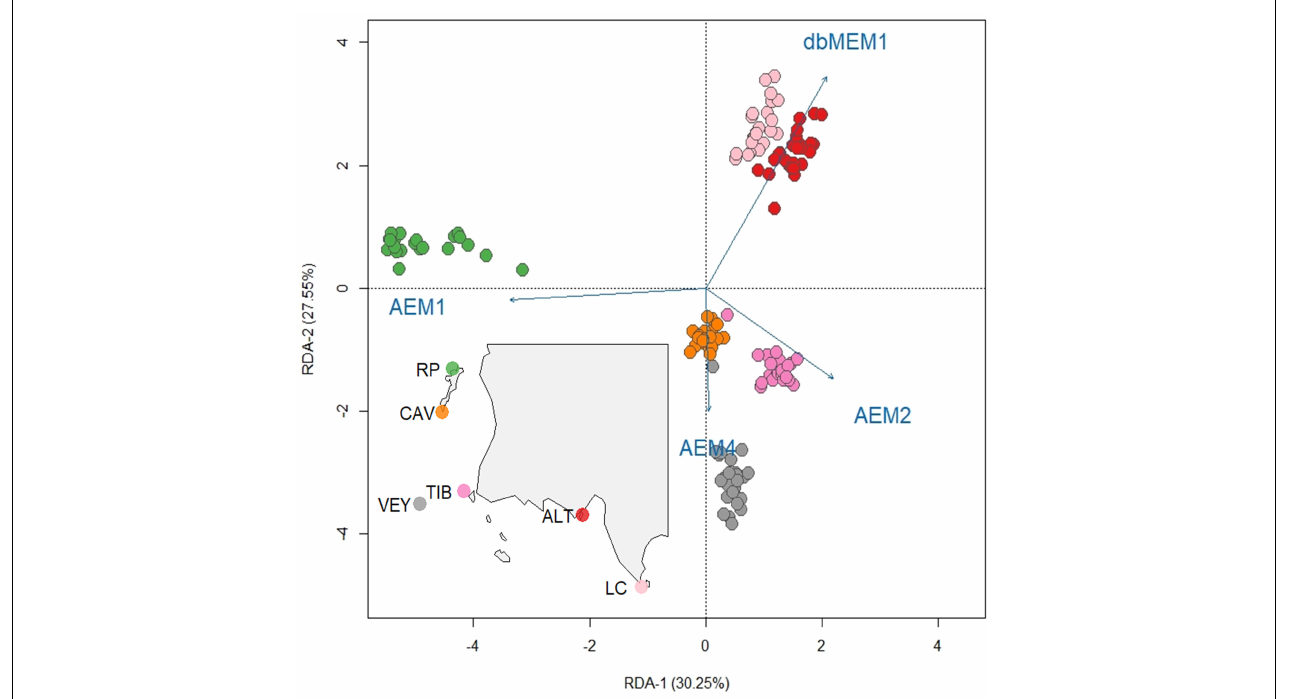
FIGURE 8 | Distance-based RDA (db-RDA) using the set of 10,755 putatively neutral SNPs at the Marseille-La Ciotat site. The significant predictors are indicated by the directional vectors in the biplot (RDA axes 1 and 2) and individuals are represented as dots and are colored according to their population reported on the sampling map (bottom left